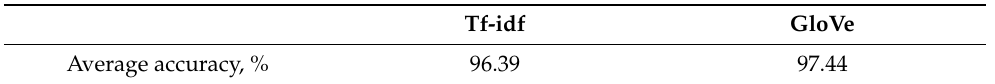
Table 4. The average recognition accuracy of different financial operations using accountant com- ments and tf-idf and GloVe